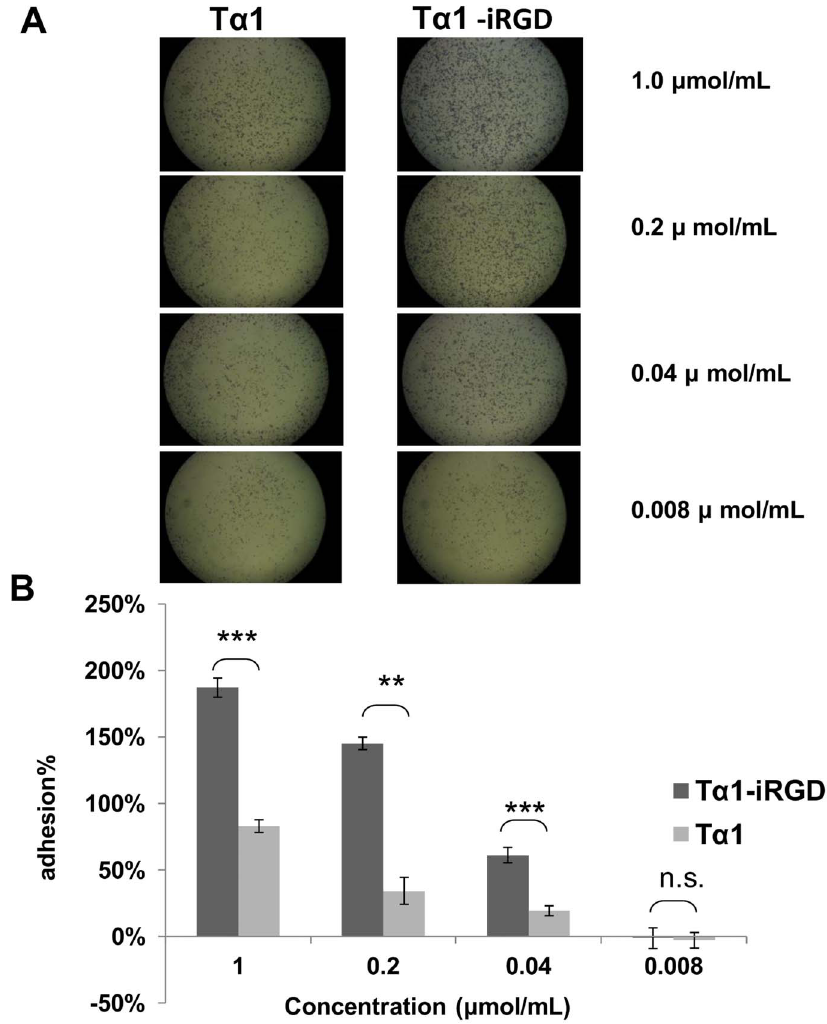
Figure 4. Enhanced cell attachment effect by adding iRGD to the C-terminus of T a 1. A. First, cells bound to the wells were fixed, stained by 0.5% crystal violet staining buffer and photographed. B. Second, crystal violet was extracted and the remaining adherent B16F10 Melanoma Cells were recorded by a microplate spectrophotometer at 595 nm wavelengths. All data are expressed as the mean 6 standard deviation, n=3. Statistical analyses were performed with Student’s t-test, n.s., not significant; *p , 0.05; **p , 0.01; ***p , 0.001.